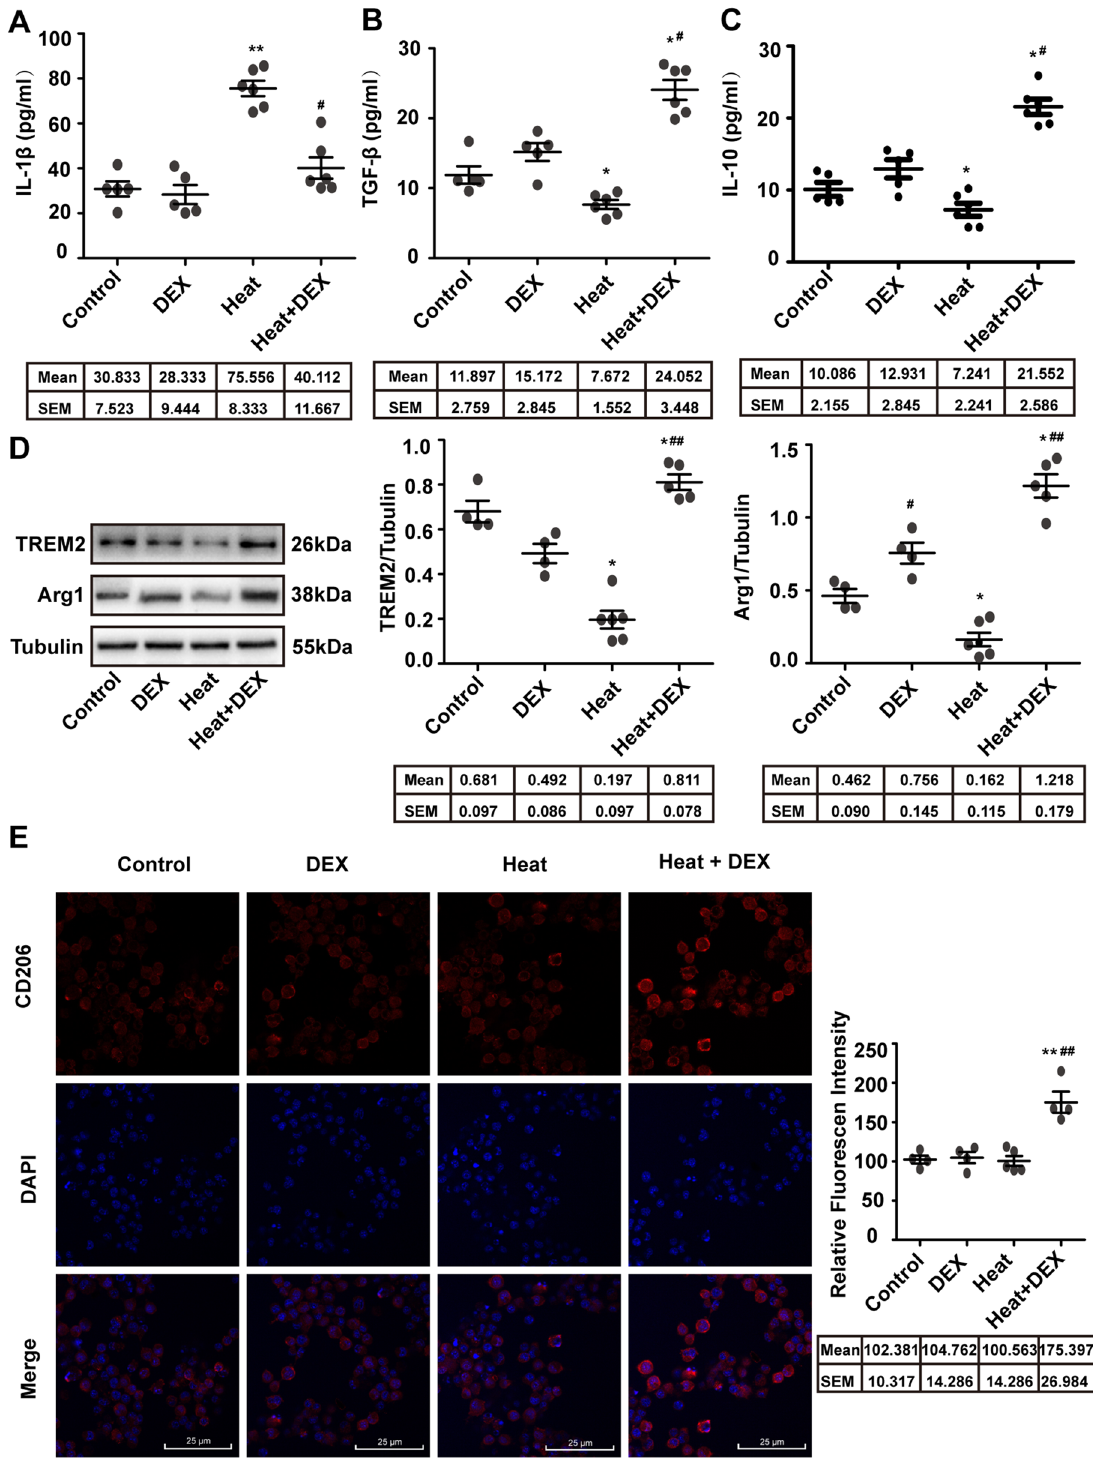
Figure 3. DEX promotes the transition of BV-2 microglia to the neuro-protective type. BV-2 cells were pretreated with or without DEX (16 µg/ml), and then subjected to heat exposure at 42 °C for 2 h, followed by a 6-h recovery period at 37 °C. ( A – C ) The protein levels of IL-1β, TGF-β and IL-10 were assayed by ELISA. ( D ) The expression of TREM2 and Arg1 in BV-2 cells was determined by Western blotting. ( E ) Confocal immunofluorescence microscopy was performed on cells that were immunoreacted with antibodies against CD206 after treatment. The images are presented at a magnification of X400. The data are shown as the mean ± SEM of three independent experiments. Statistical analysis: two-way ANOVA. * p < 0.05, ** p < 0.001 vs. Control. # p < 0.05, ## p < 0.001 vs.